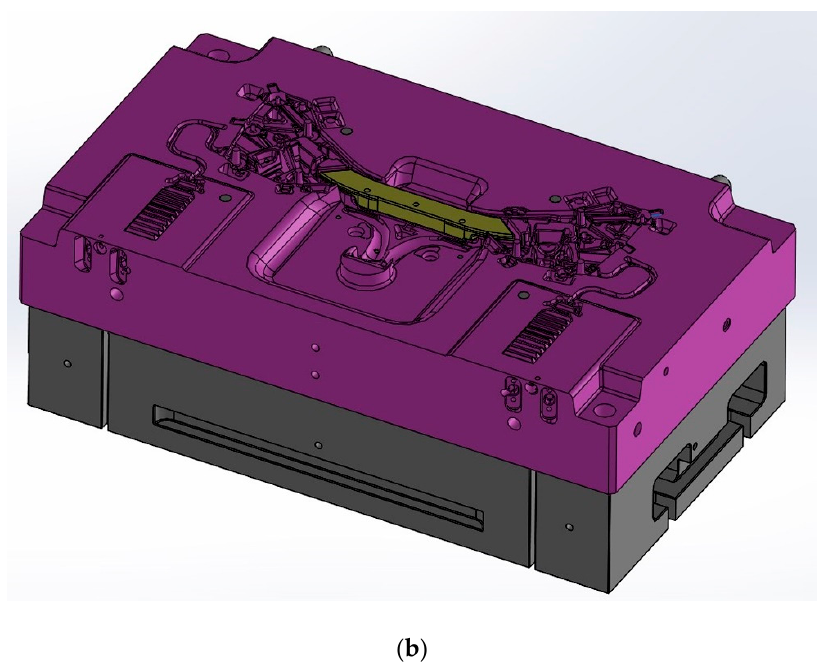
Figure 2. ( a ) 3D model of the closed profile crossbeam with ceramic core. ( b ) The geometry and the positioning solutions in the mold cavity adopted for the ceramic core.